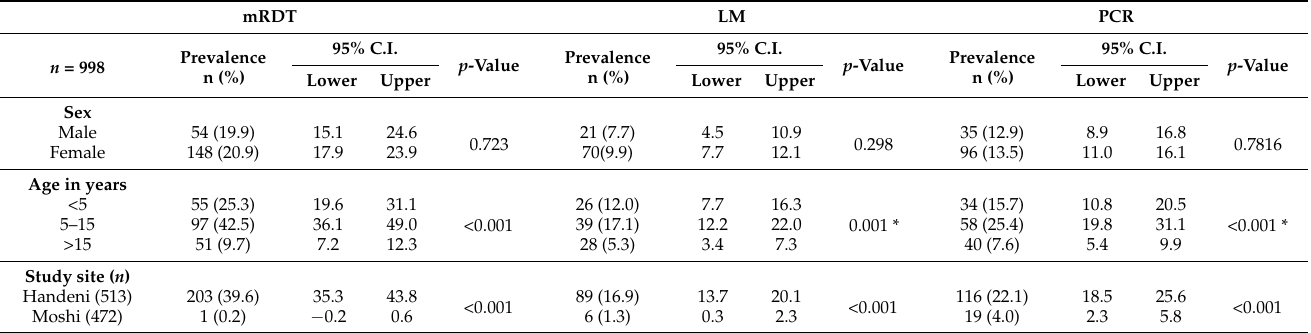
Table 1. Malaria prevalence by mRDT, LM and PCR across age groups in Handeni and Moshi sites. LM